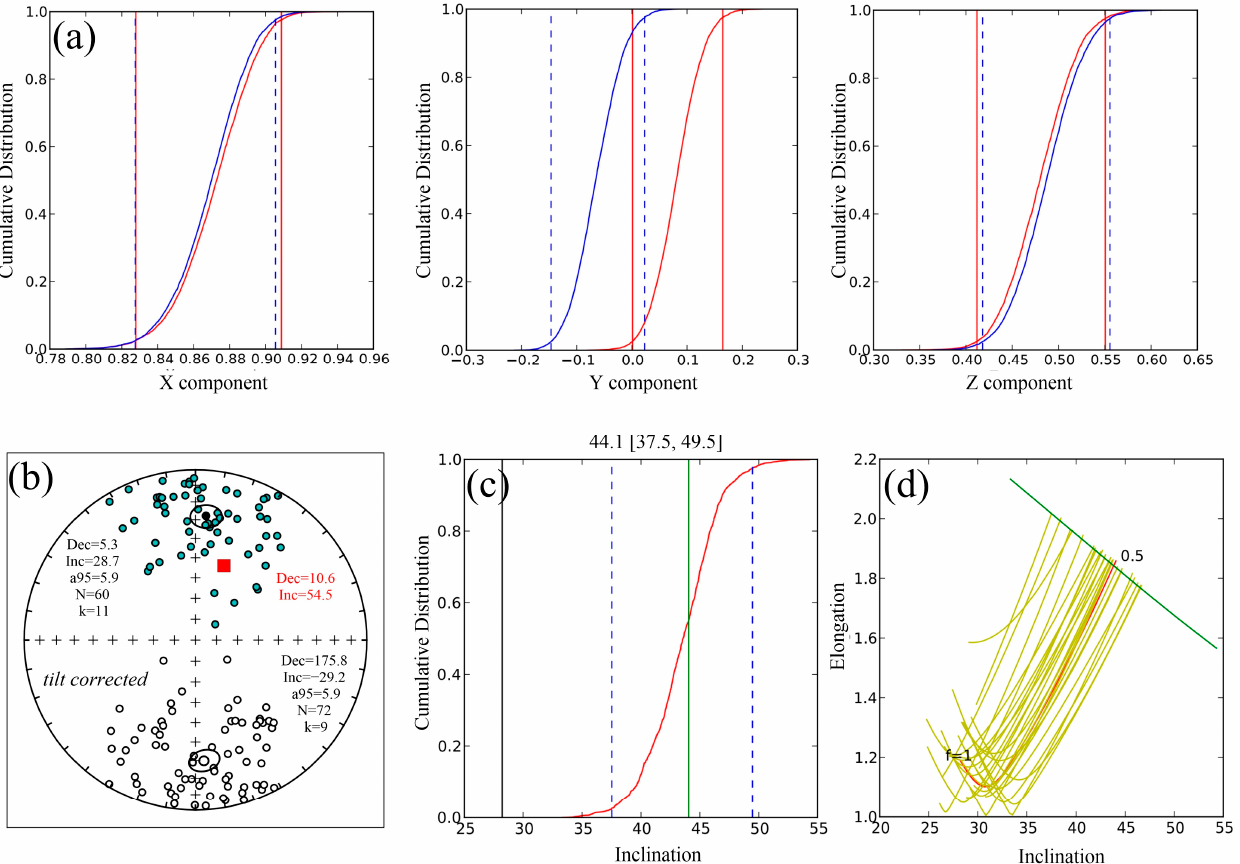
Figure 9. ( a ) Results of the reversal test of the paleomagnetic data of the Tuotuohe Formation from the TTH section [28] and the data from this study. ( b ) Equal area projection of the data from ( a ) and the principal direction of the normal and reverse polarities; also shown is the principal direction of the expected mean direction at 35 Ma (red rectangle) for the Tuotuohe Formation. ( c ) Plots of the cumulative distribution of the corrected inclination calculated in 2000 bootstrap runs (red). The black and green vertical lines show the uncorrected and corrected inclination, respectively. Confidence bounds containing 95% of the bootstrap results are shown as two dashed blue lines. ( d ) Application of the E/I method to the directional dataset. The red curves show the elongation versus inclination upon stepwise unflattening of the dataset by gradually decreasing the flattening factor ( f ). The dark green curve is the elongation versus inclination curve predicted by the TK03.GAD model [61]. The intersection between these two curves provides the flattening factor used in the correction for inclination shallowing, as indicated in the plots.